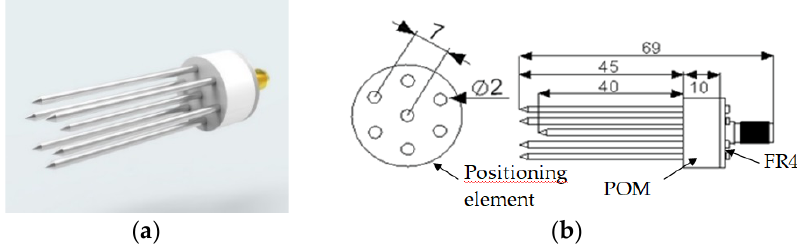
Figure 1. Tested seven-rod probe and the elements of the measurement setup; ( a ) a probe; ( b ) respective Figure.1. Tested seven- rod probe and the elements of the measurement setup; ( a ) a probe ; ( b ) dimensions of the probe (dimensions in respective dimensions of the probe (dimensions in mm).